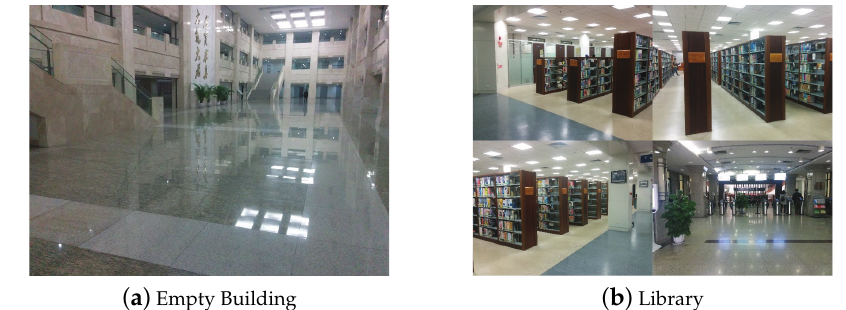
Figure 2. Experiment Environments.